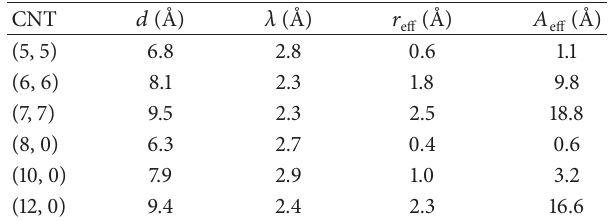
for different eff